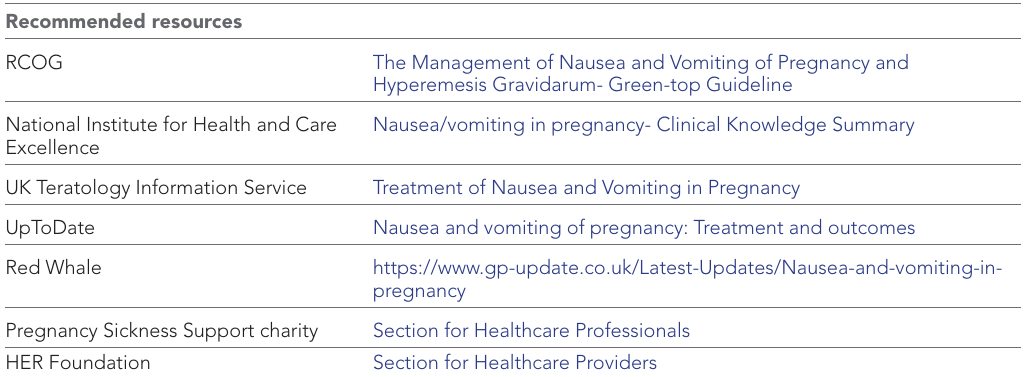
Table 3 List of recommended resources for healthcare